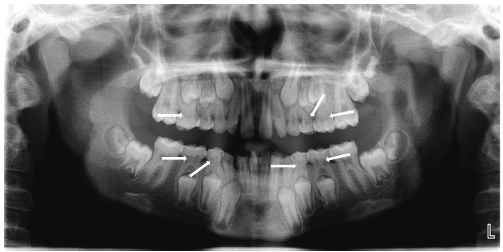
Figure 1: OPG revealing pulp stones and taurodontism in all primary molars (Case 1).